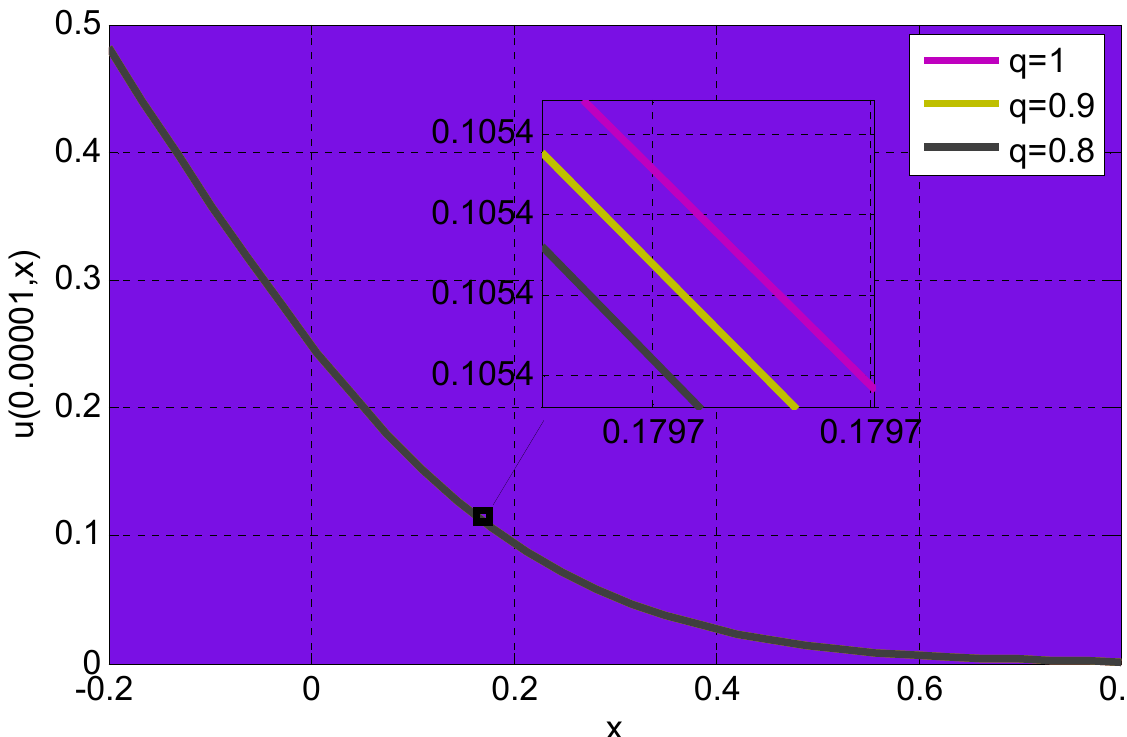
Figure 3. Impact of q on the solution of the problem in Example 1. Example 2. Flow over flat and oscillator sheet.